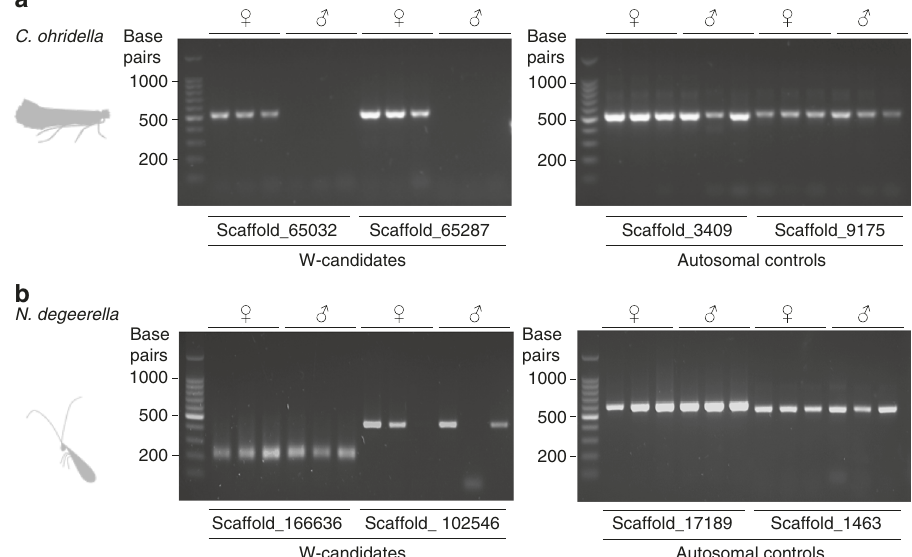
Fig. 5 Evidence of a W chromosome in C. ohridella but not in N. degeerella . Ampli fi cation patterns of genomic DNA from three females and three males are shown for two W-candidates, and for two autosomal control genes in a C. ohridella and b N. degeerella . The molecular size marker is indicated on the left (100 bp ladder). Results for all W-candidates are shown in Supplementary Fig.